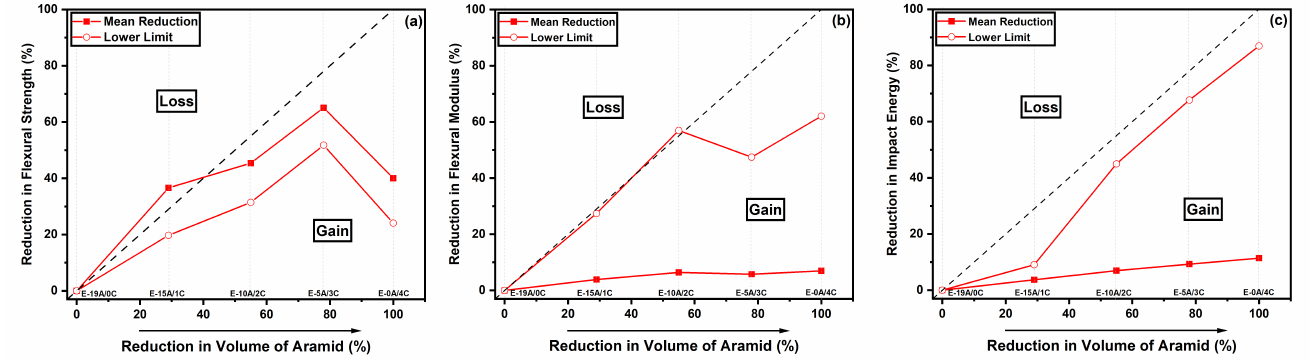
Figure 6. Reduction maps for flexural and impact properties of hybrid curaua–aramid composites: ( a ) flexural strength ( σ f ); ( b ) flexural modulus (E f ); and ( c ) impact